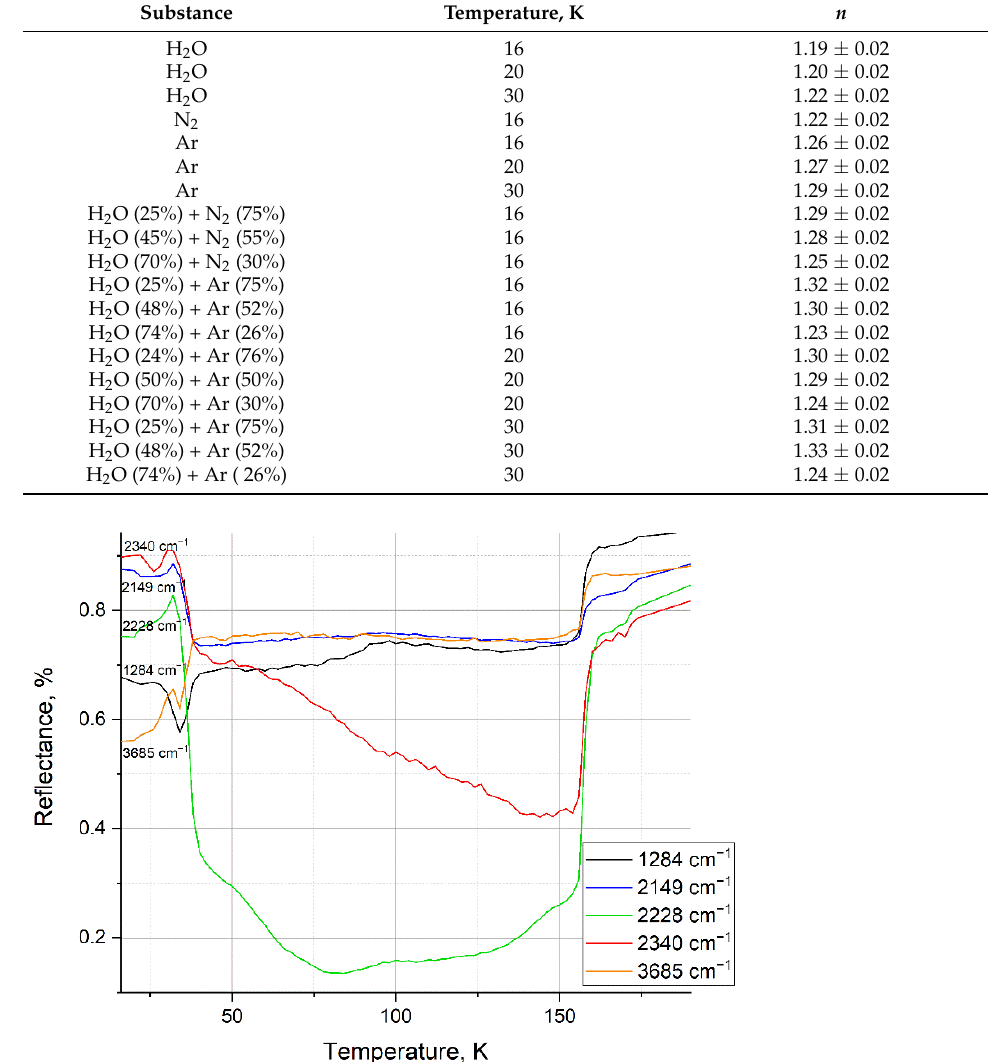
Figure 7. Thermogram for a mixture of water and nitrogen condensed at 16 K.